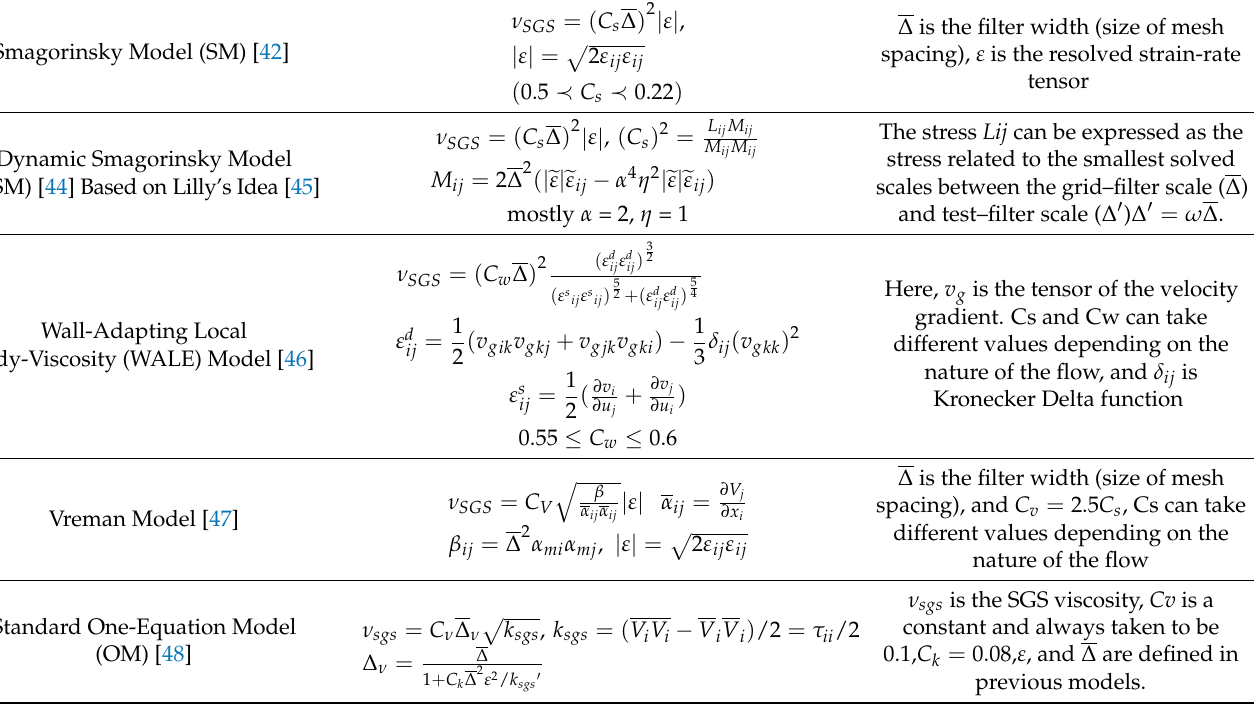
Table 1. Displays each SGS model’s formulation for sub-grid scale